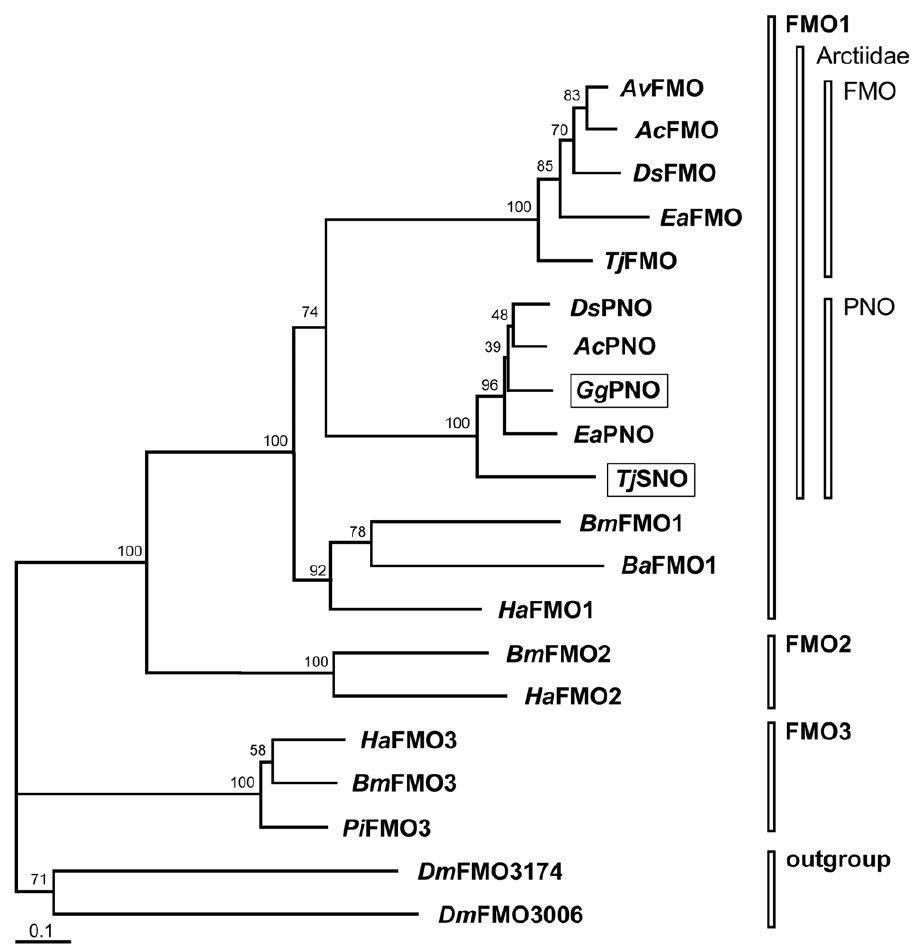
Figure 4. Rooted neighbor-joining tree of amino acid sequences derived from cDNA encoding lepidopteran FMOs with two sequences of D.melanogaster as the outgroup. Theframed sequences were experimentally characterized as SNOandPNO, respectively, whereas the others should be regarded as putative FMO-coding cDNA. Branch lengths are proportional to the number of substitutions per site (scale: 0.1 substitutions per site). Bootstrap proportions resulted from 1000 replicates. Ac , Arctia caja ; Av , Arctia villica ; Ba , Bicyclus anynana ; Bm , Bombyx mori ; Dm , Drosophila melanogaster ; Ds , Diacrisia sannio ; Ea , Estigmene acrea ; Gg , Grammia geneura ; Ha , Helicoverpa armigera ; Pi , Plodia interpunctella ; Tj , Tyria jacobaeae .